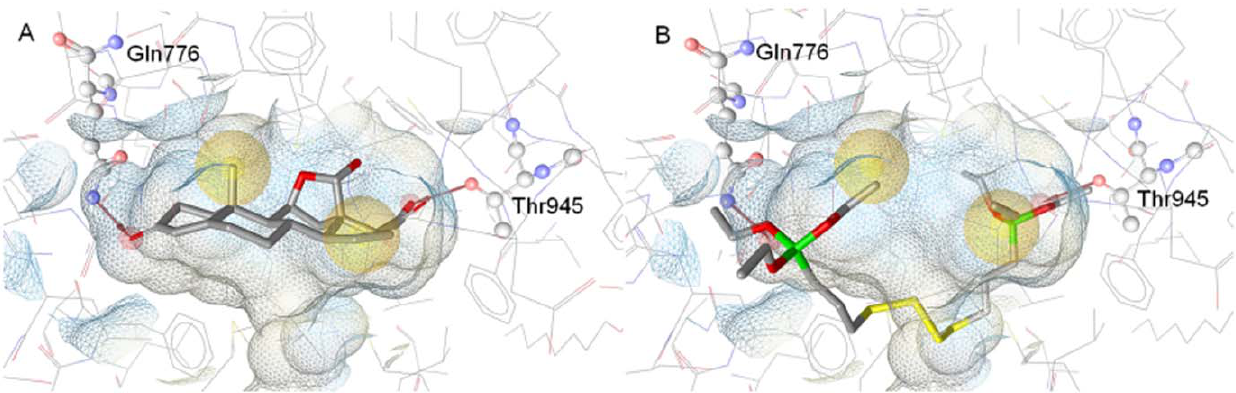
Figure 7. Binding of aldosterone and the silane AB110873 to the MR. A , MR pharmacophore model with the cocrystallized ligand aldosterone. B, the silane AB110873 fitted to the MR ligand binding site with the pharmacophore model. Hydrogen bond acceptors are shown as red arrows, hydrophobic areas as yellow spheres. Exclusion volumes are not shown for clarity. Receptor binding pocket is colored by aggregated lipophilicity (grey)/hydrophilicity (blue).